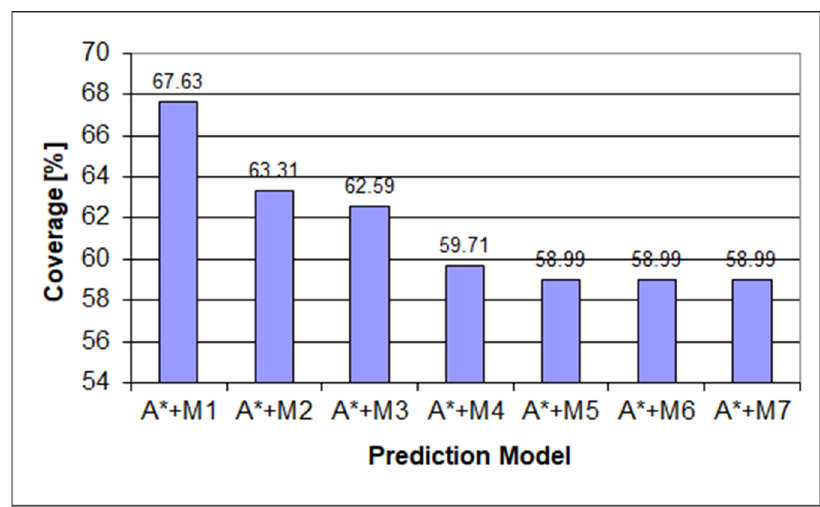
Figure 7. Predictor coverage graph for the perfect heuristic on the mixed dataset.